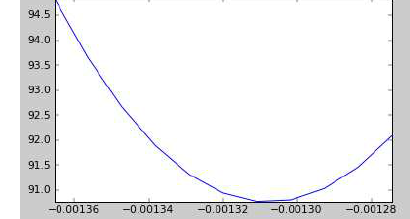
Figure 10 : MTF computation residues vs. best focus hypothesis